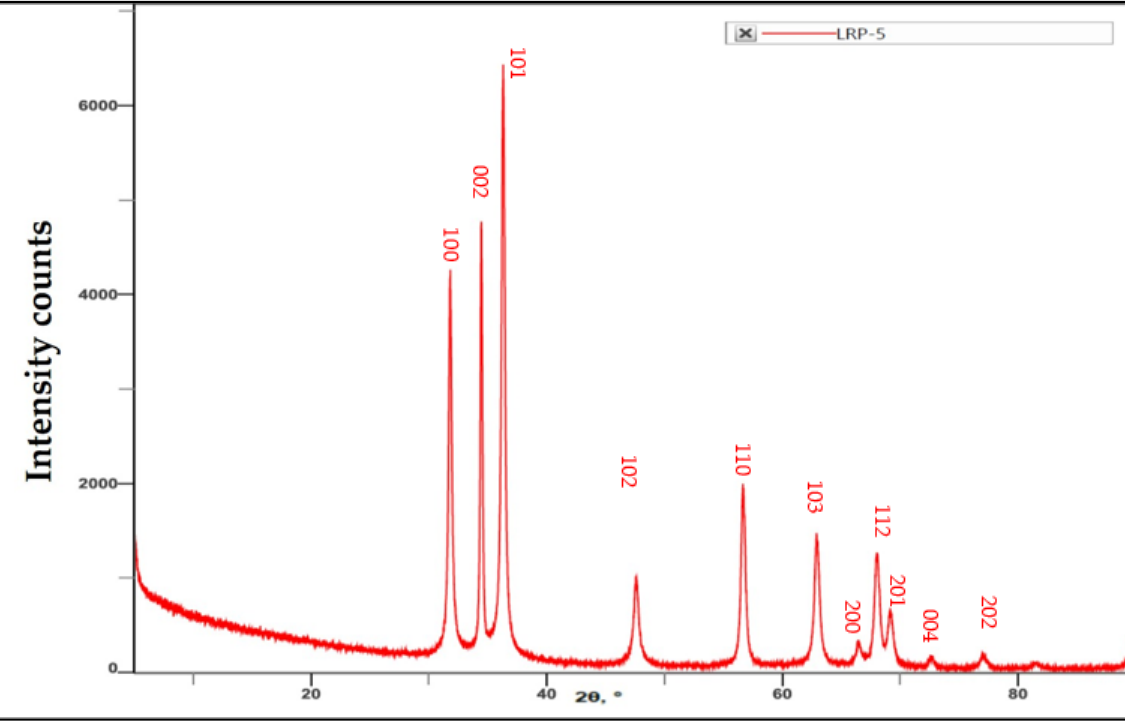
Figure 8. The X-ray diffraction patterns of ZnO nanoparticles prepared from R. sativus